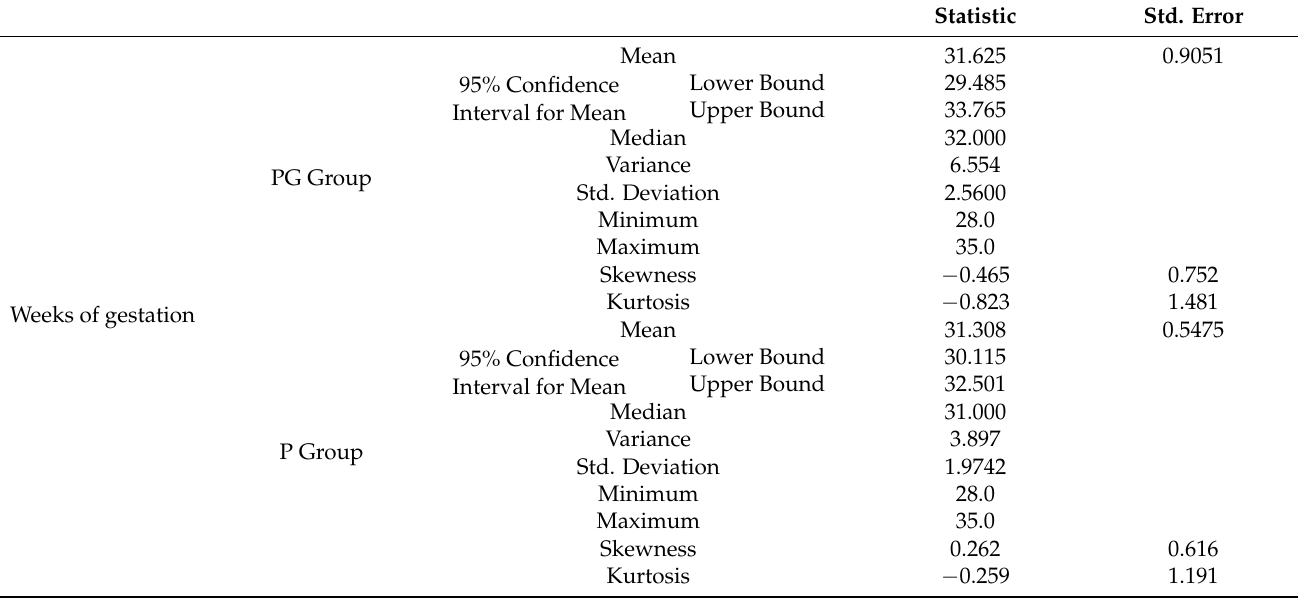
Table 2. Weeks of gestation in both